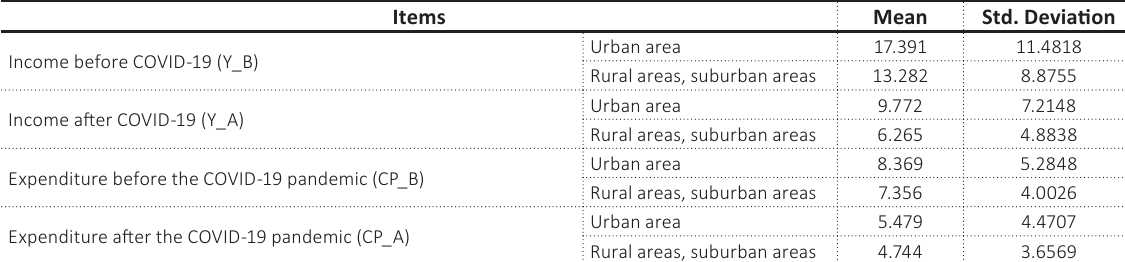
Table 2. Statistical results describing income and expenditure before and after the COVID-19 pandemic between two groups of people in urban and other